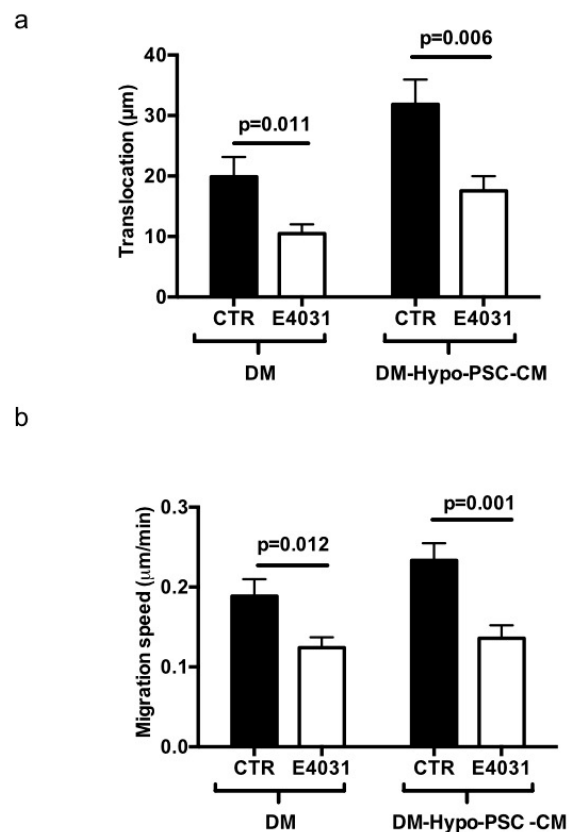
Figure 7. Cell migration in PANC-1 cells cultured onto DM and DM plus Hypo-PSC-CM. Cells were incubated for 24h on DM in the absence (non-conditioned medium, NCM) or in the presence of conditioned medium (human pancreatic stellate cells (PSCs)-conditioned medium, PSC-CM), in the absence (CTR) or in the presence of 40 µ M E4031 (E4031). Conditioned medium was collected from PSCs grown in hypoxia (1% O 2 ) (Hypo-PSC-CM). The translocation ( a ) and migration speed ( b ) are increased upon treatment with conditioned medium. This effect is largely reversed by K V 11.1 channel inhibition. K V 11.1 channel inhibition elicits larger effects in PANC-1 cells stimulated with hypoxic conditioned medium. Data are reported as mean ± SEM. All p -values were determined by a t -test (significant level set to p < 0.05), or for data deviating from normality by a Kolmogorov–Smirnov test.